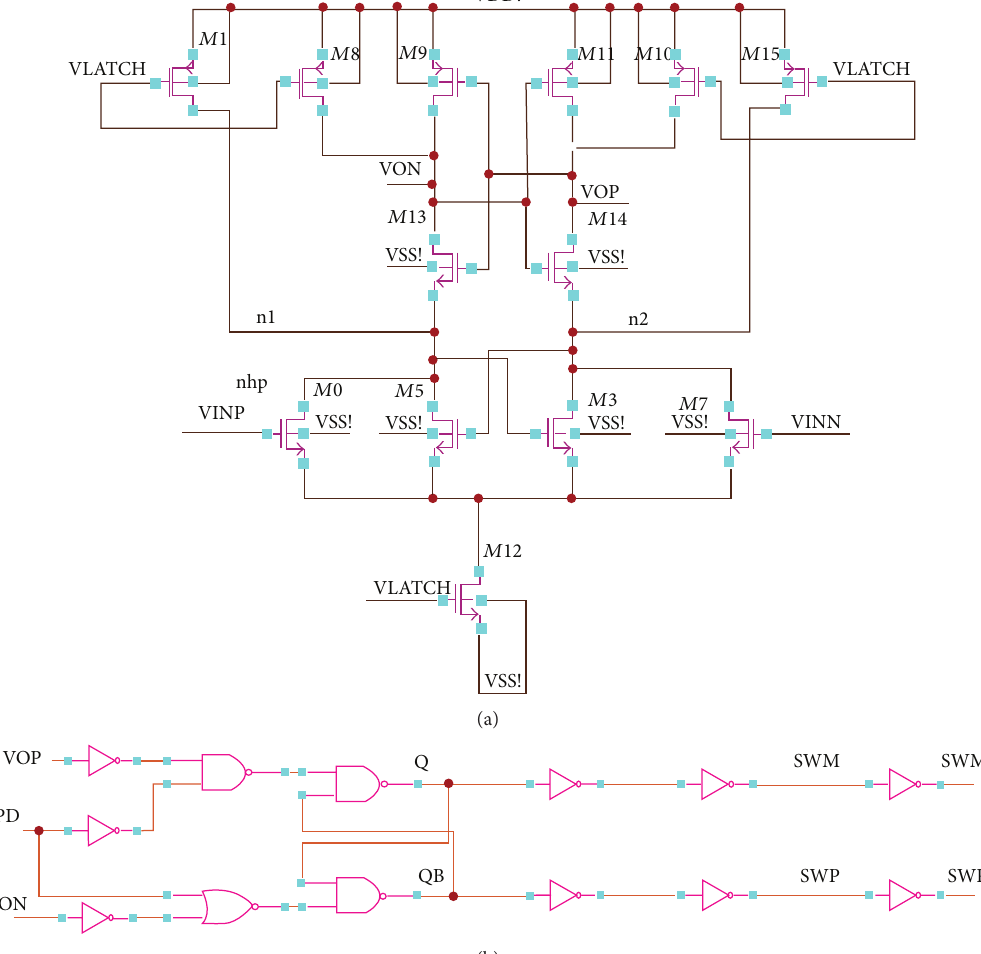
Figure 1: (a) Schematic diagram of the proposed differential pair dynamic latch comparator and (b) schematic diagram of the R-S flip-flop with digital signal